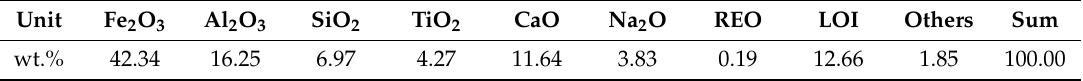
Table 1. Bauxite residue chemical analysis. Note: REO, rare earth oxides; LOI, loss of ignition. Unit wt.%